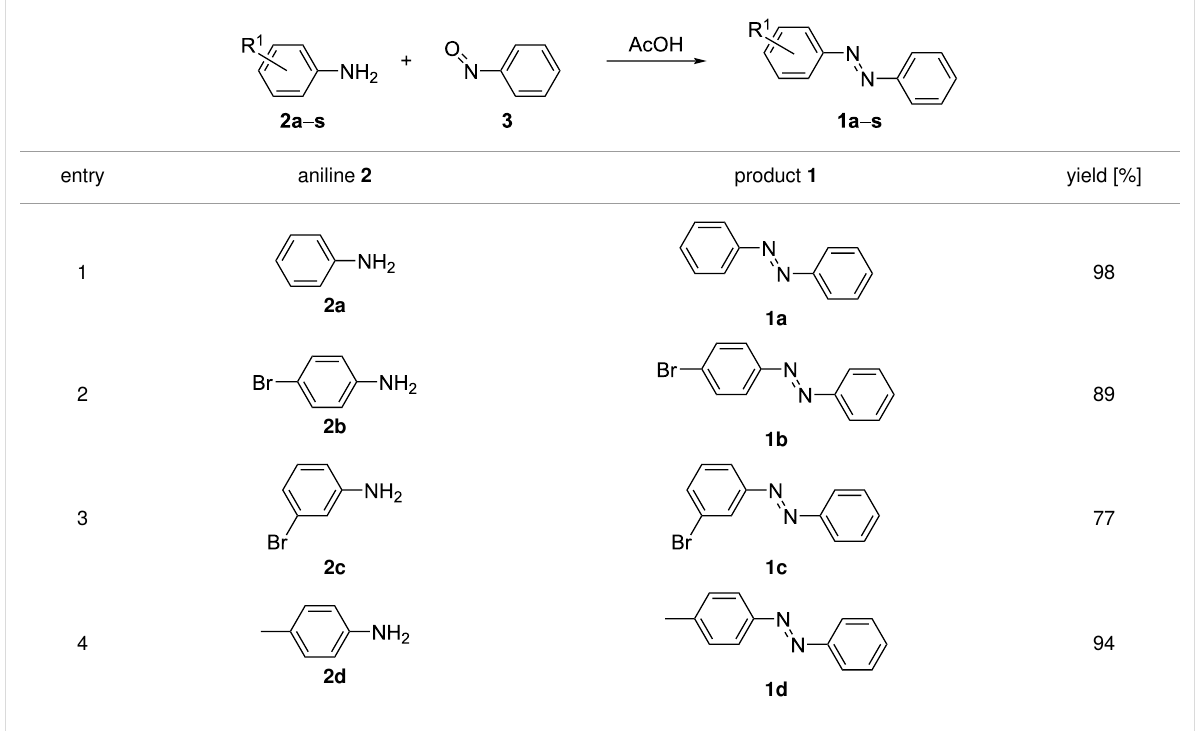
Table 1: Substrate scope of the Baeyer–Mills reaction under the optimized conditions in continuous flow.